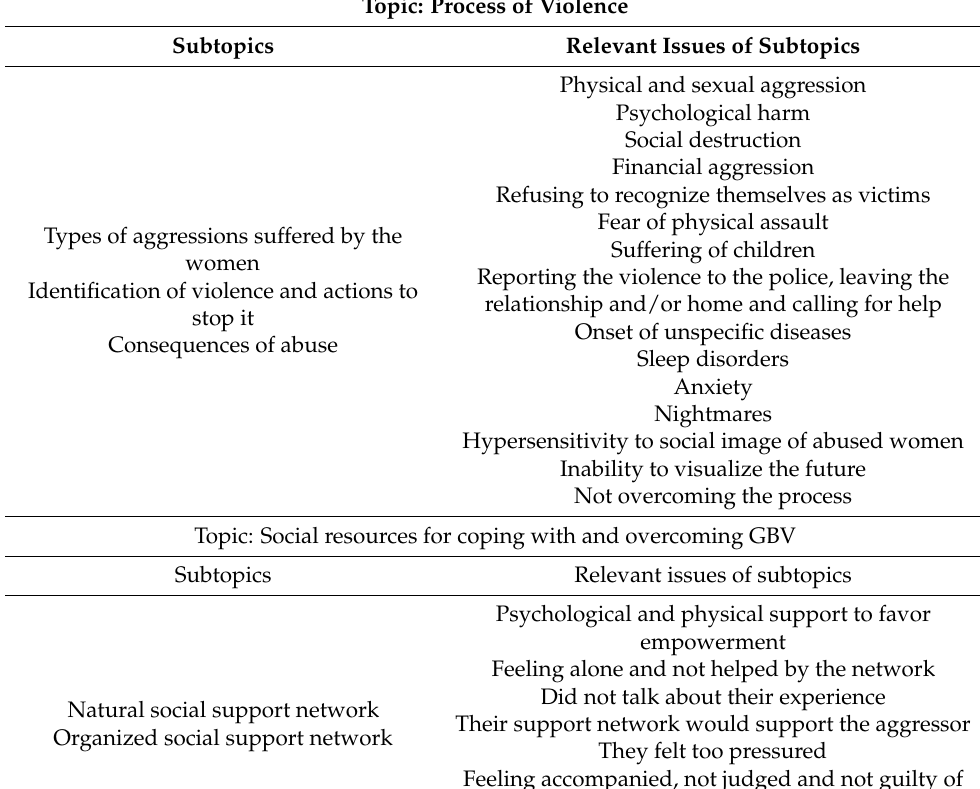
Topic: Process of Violence Relevant Issues of